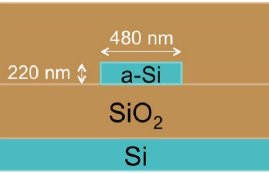
Figure 1. Amorphous silicon waveguide cross section. The thickness of the SiO 2 layer is 1.7 μ m [28].